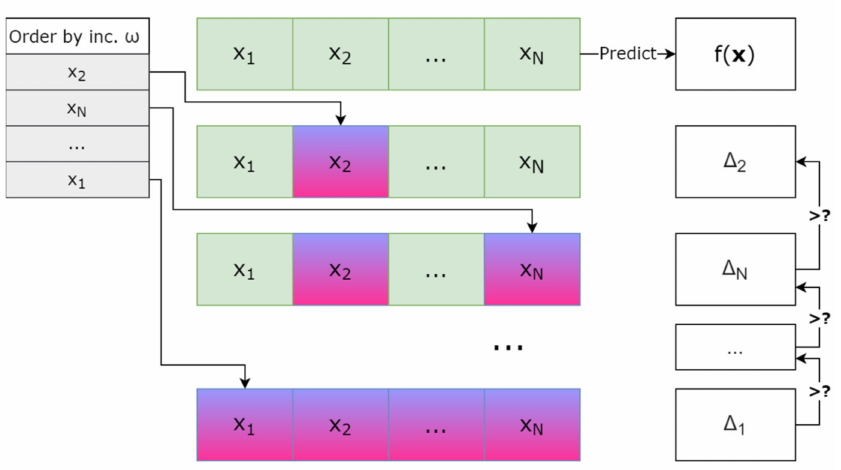
Figure 3. Scheme of the algorithm for calculating the Monotonicity